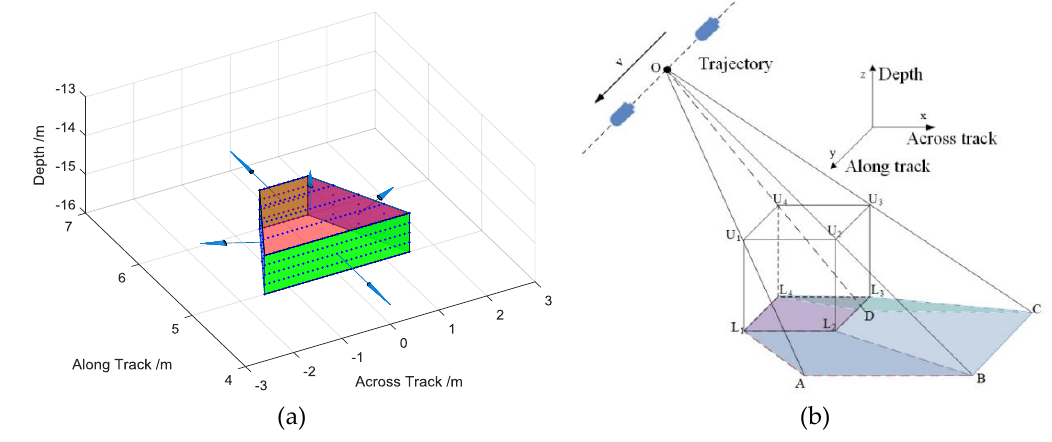
Figure 7. Target simulation model: ( a ) normal vector of target surface; ( b ) shadow area of target calculated from the carrier position.